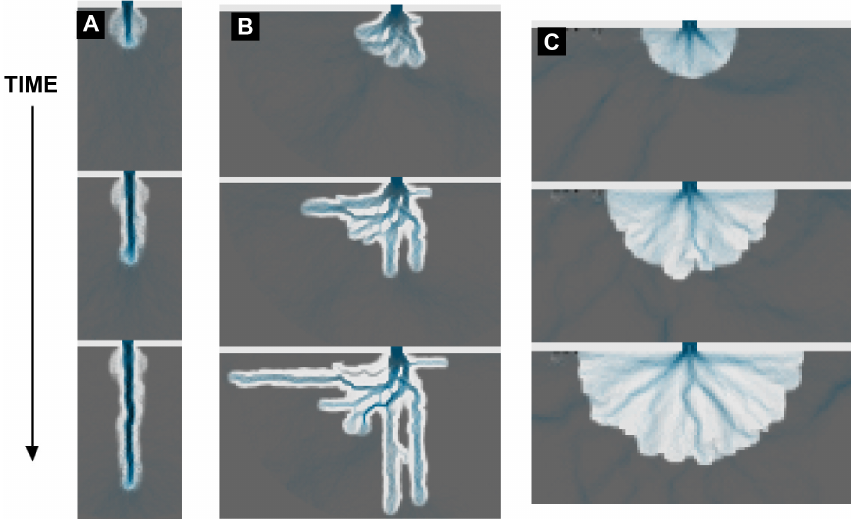
Figure 14. Effects of model parameters. (a) An elongated channel is formed with 50% sand input by switching off the influence of water surface in routing water flow (i.e., setting parameter γ to zero). (b) Multiple elongated channels are formed with 0% sand (100% mud) input without modifying any parameter values. (c) A fan delta is formed with 100% sand input which shows that a stable channel network with levees cannot be achieved with only